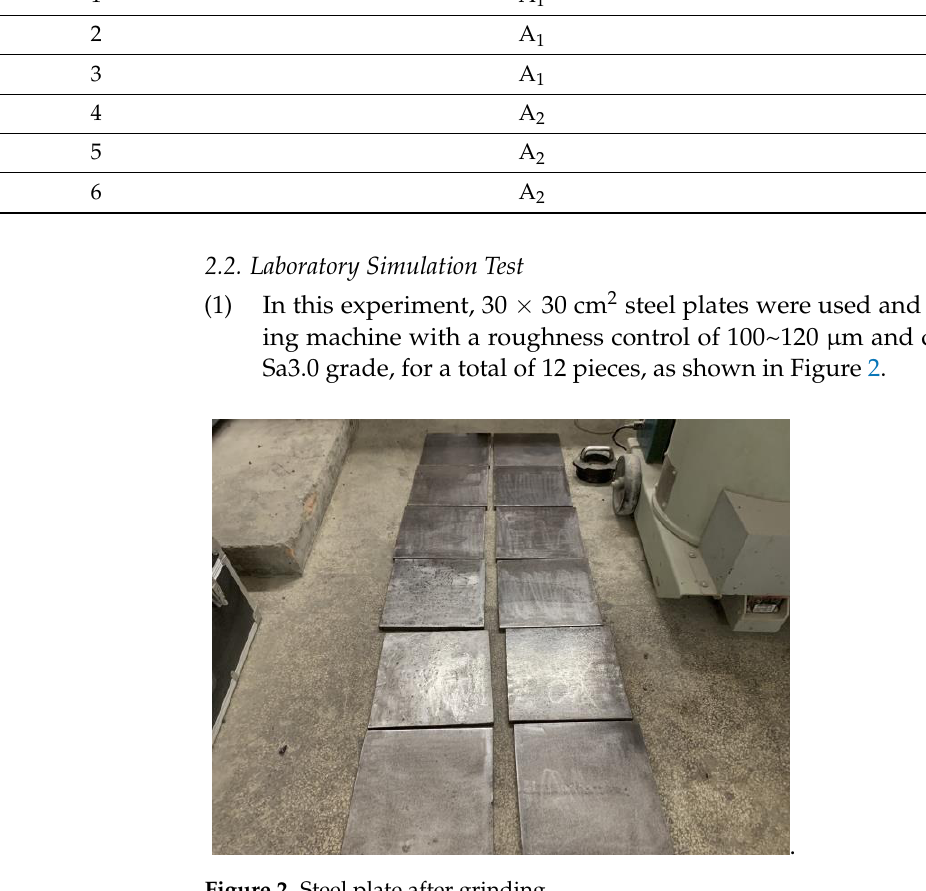
Figure 2. Steel plate after grinding.